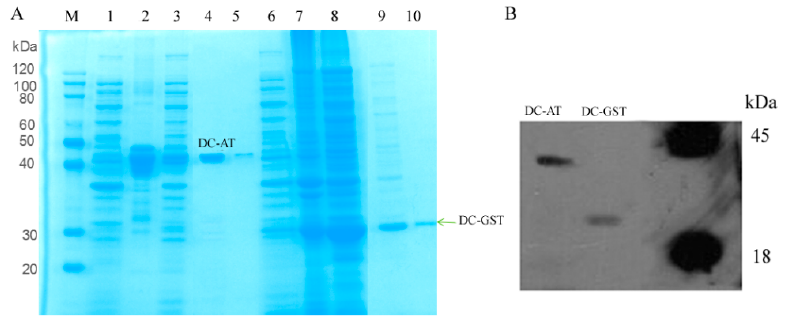
Figure 4. The expression and purification of DC-AT (The aminotransferase encoded by GliI from D. cejpii) and DC-GST (glutathione S- transferase from D. cejpii ): ( A ) The expression and purification of